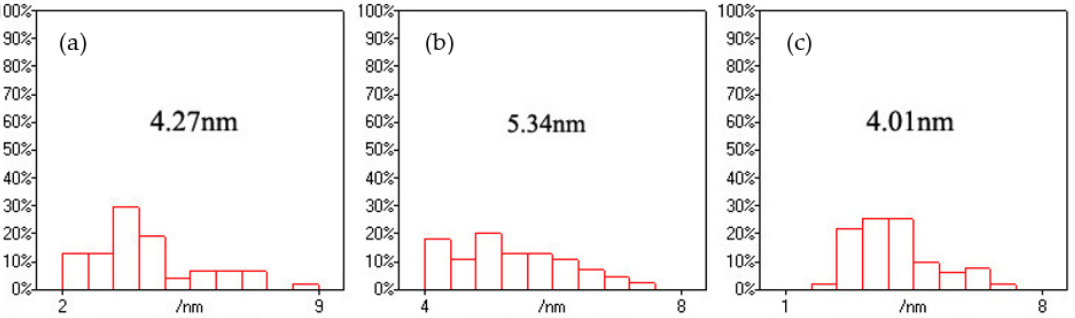
Figure 2. The size distributions of the CdS nanoparticles with different –COOH/CdS ratios; ( a ) –COOH/Cd 2+ = 0.5; ( b ) –COOH/Cd 2+ = 1.0; and ( c ) –COOH/Cd 2+ = 2.0.